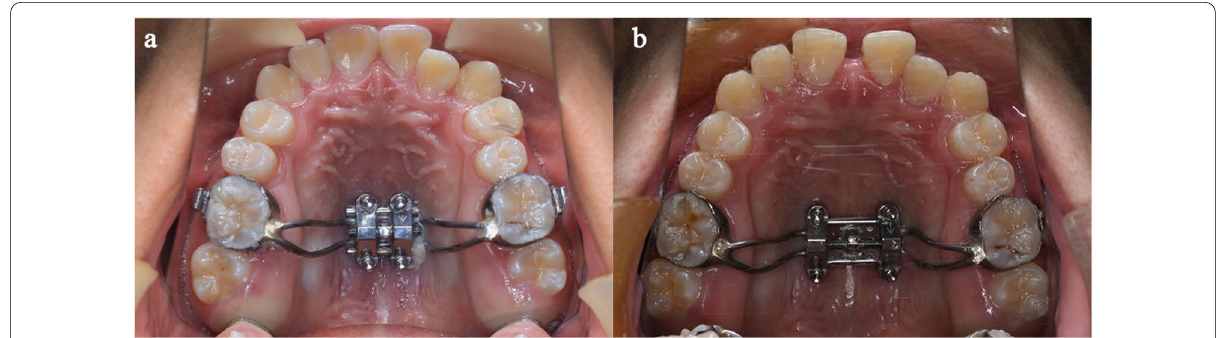
Fig.1 Intraoral view of MARPE. a before expansion; b after